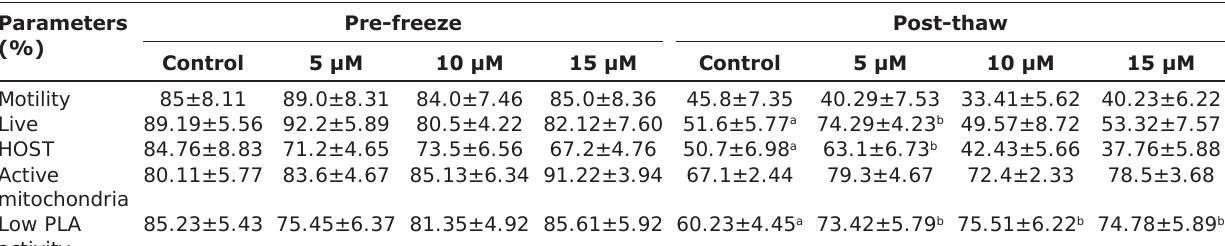
Table-1: Effects of supplementation of Bcl-2 protein at various concentrations on semen quality at pre-freeze and post-thaw stage. Parameters